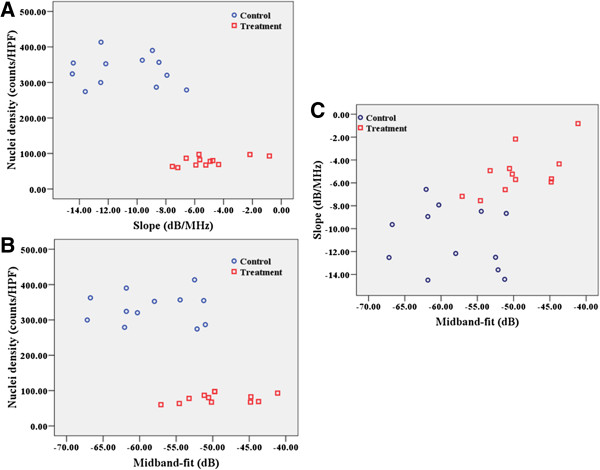
Scatter plots of changes in spectral parameters. (A) Spectral slope, (B) midband-fit versus cell nuclei density and (C) spectral slope versus midband-fit.